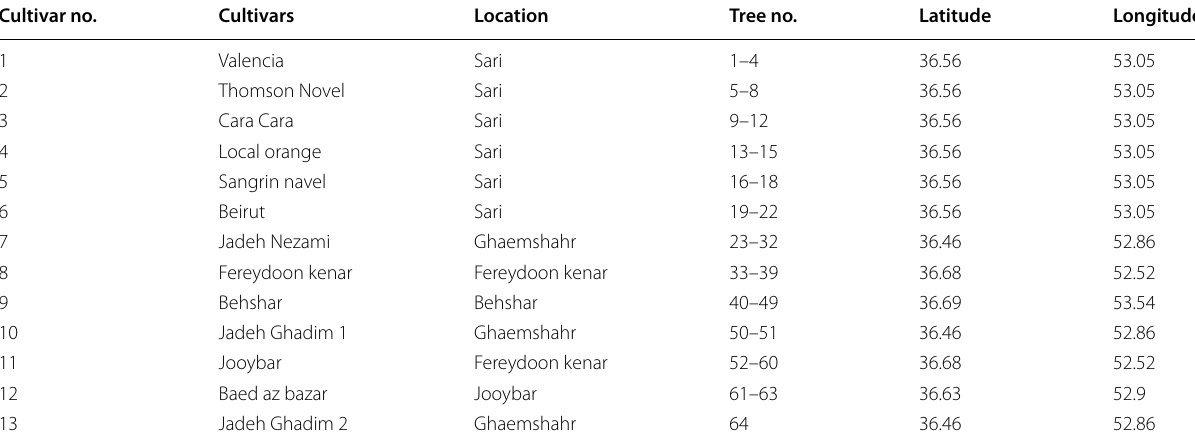
for genetic variation assay and fingerprinting in sweet oranges ( C. sinensis ) cultivars along with several tange- rines ( C. reticulata Blanco, [7, 8]). On the other hand, the homoplasy of SSR microsatellites showed that SSR mark- ers rate in DNA fragments by size. Using characterized amplified polymorphism (CAPS) markers in plant spe- cies is a suitable method to reveal sequence variations without using cost-consuming sequencing methods [15]. Table 1 Studied cultivars, their locations, latitude, and longitude Cultivar no.